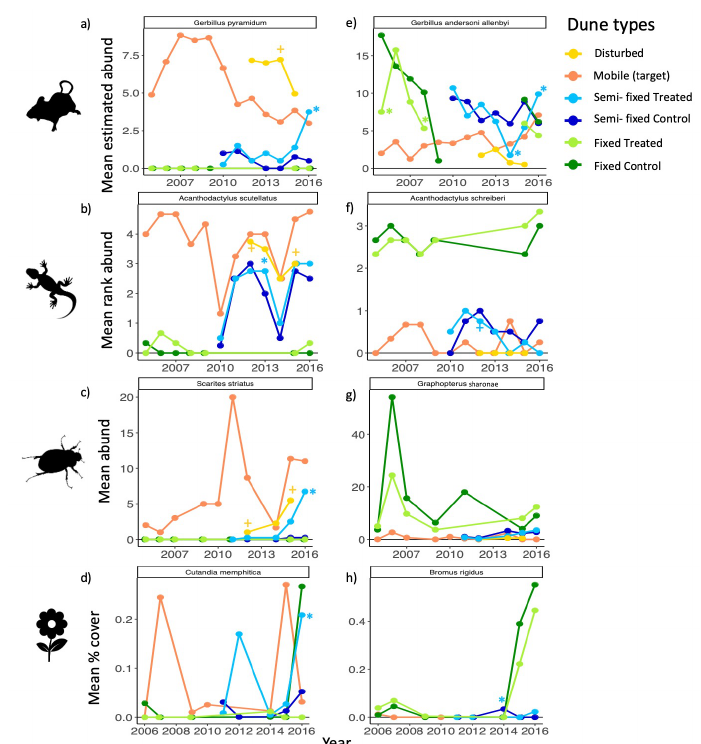
Figure 12. Temporal changes in abundance of ( a – d ) Mobile Indicator Species (MIS) and ( e – h ) Fixed Indicator Species (FIS) on di ff erent dune types for rodents, reptiles, beetles, annuals (see icons by row). Dune types were tested for significant di ff erences between treated dunes, their un-treated control pair and the reference mobile dunes each year. * and + represent p < 0.05 for treated dunes compared to control and reference dunes, respectively. Not all significant results are shown given for